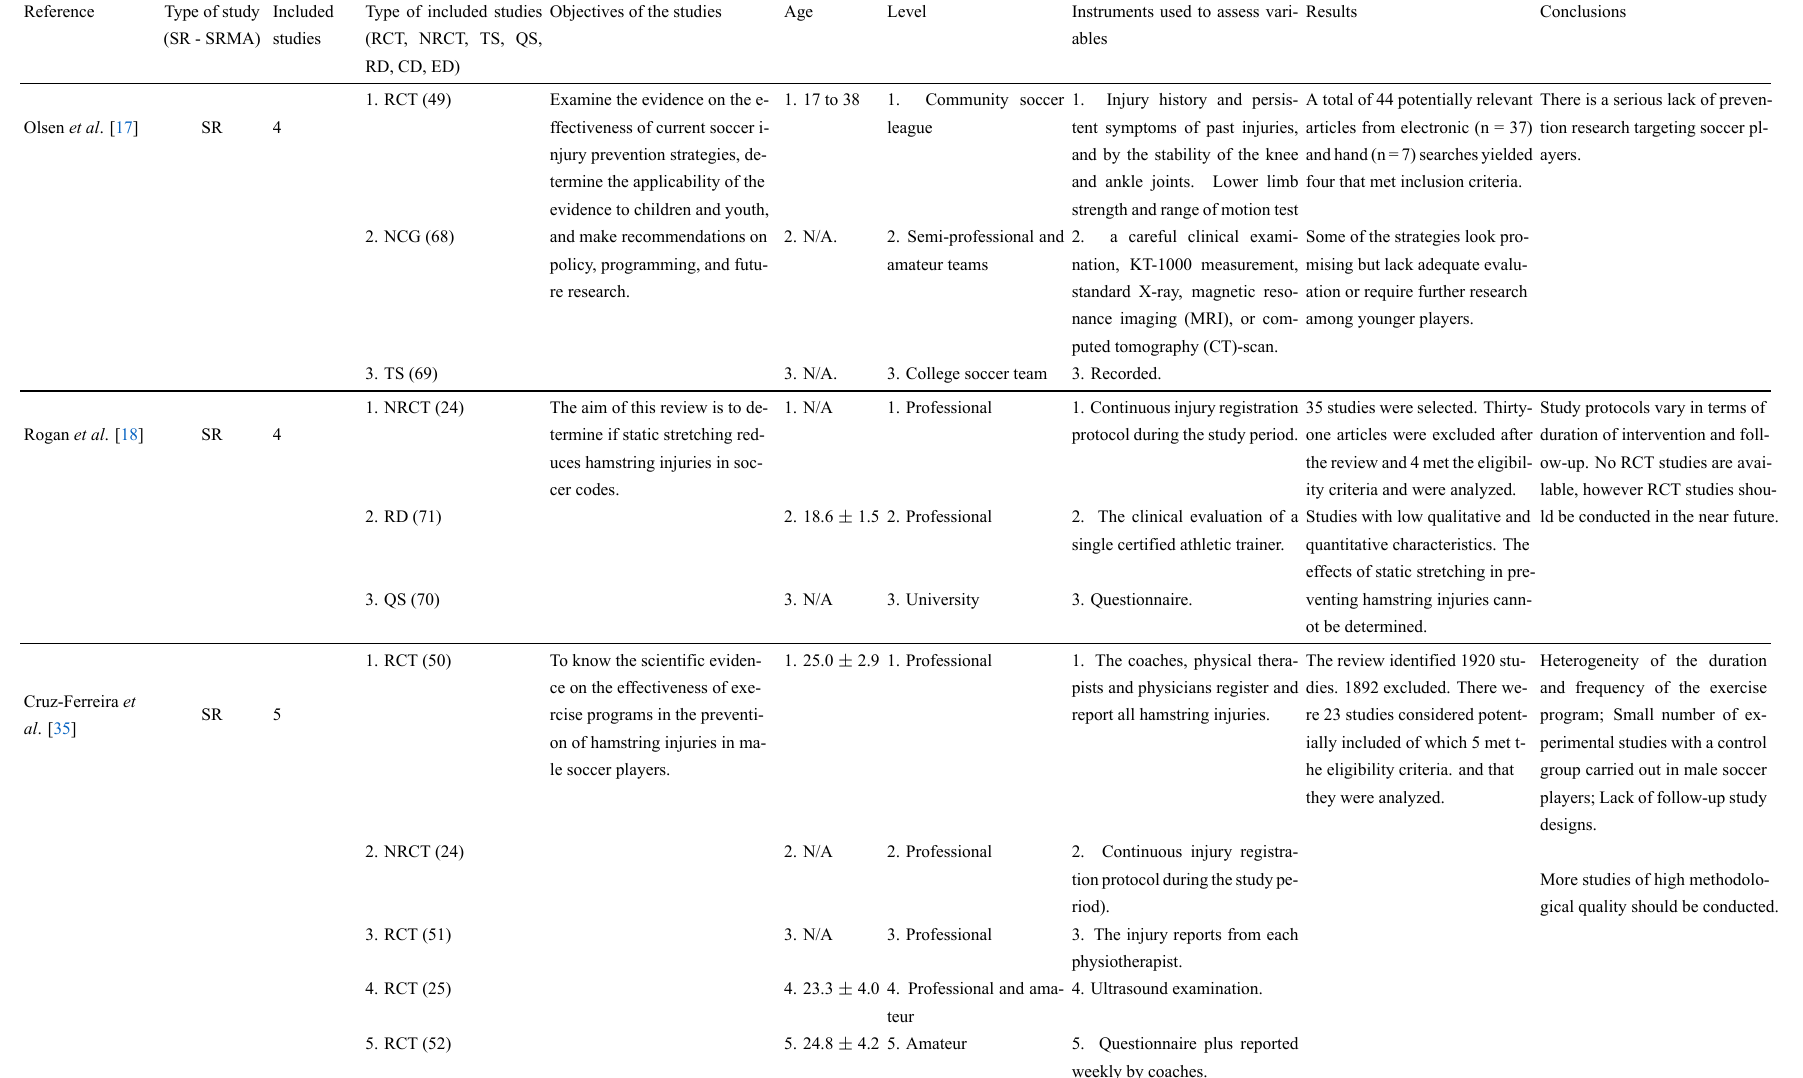
Table 3. Summary of the main findings published in the eligible articles included in the umbrella